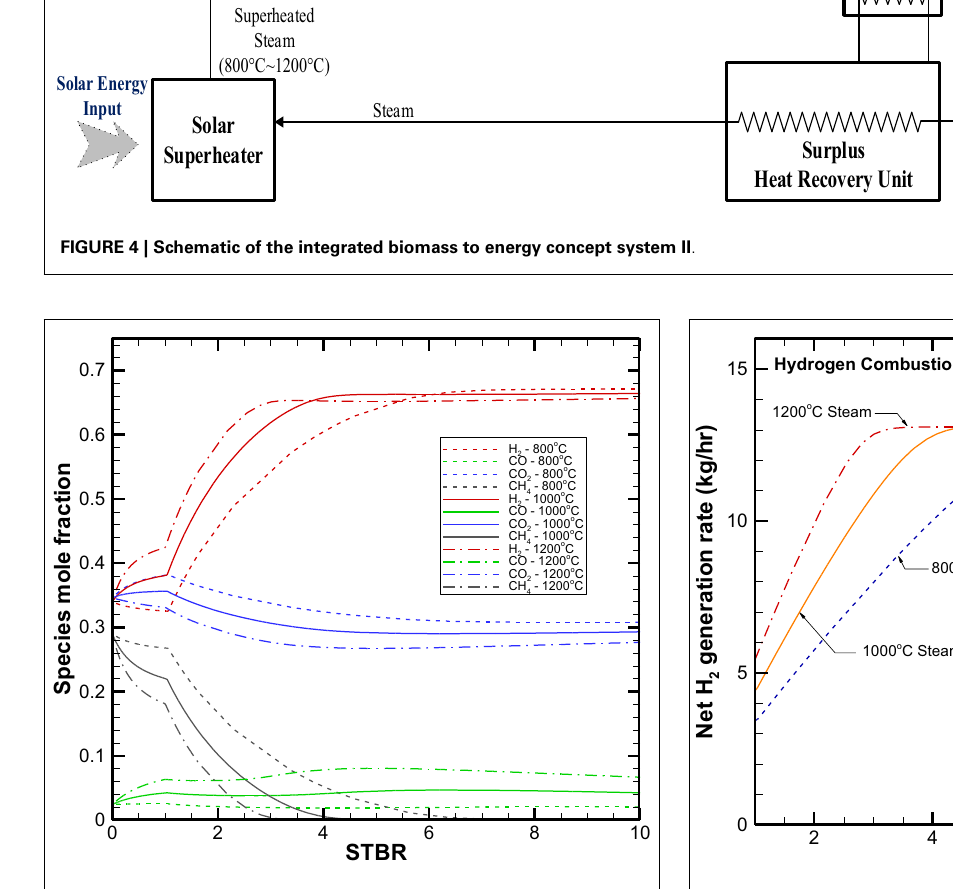
FIGURE 5 | Syngas compositions as a function of STBR and steam inlet temperature .